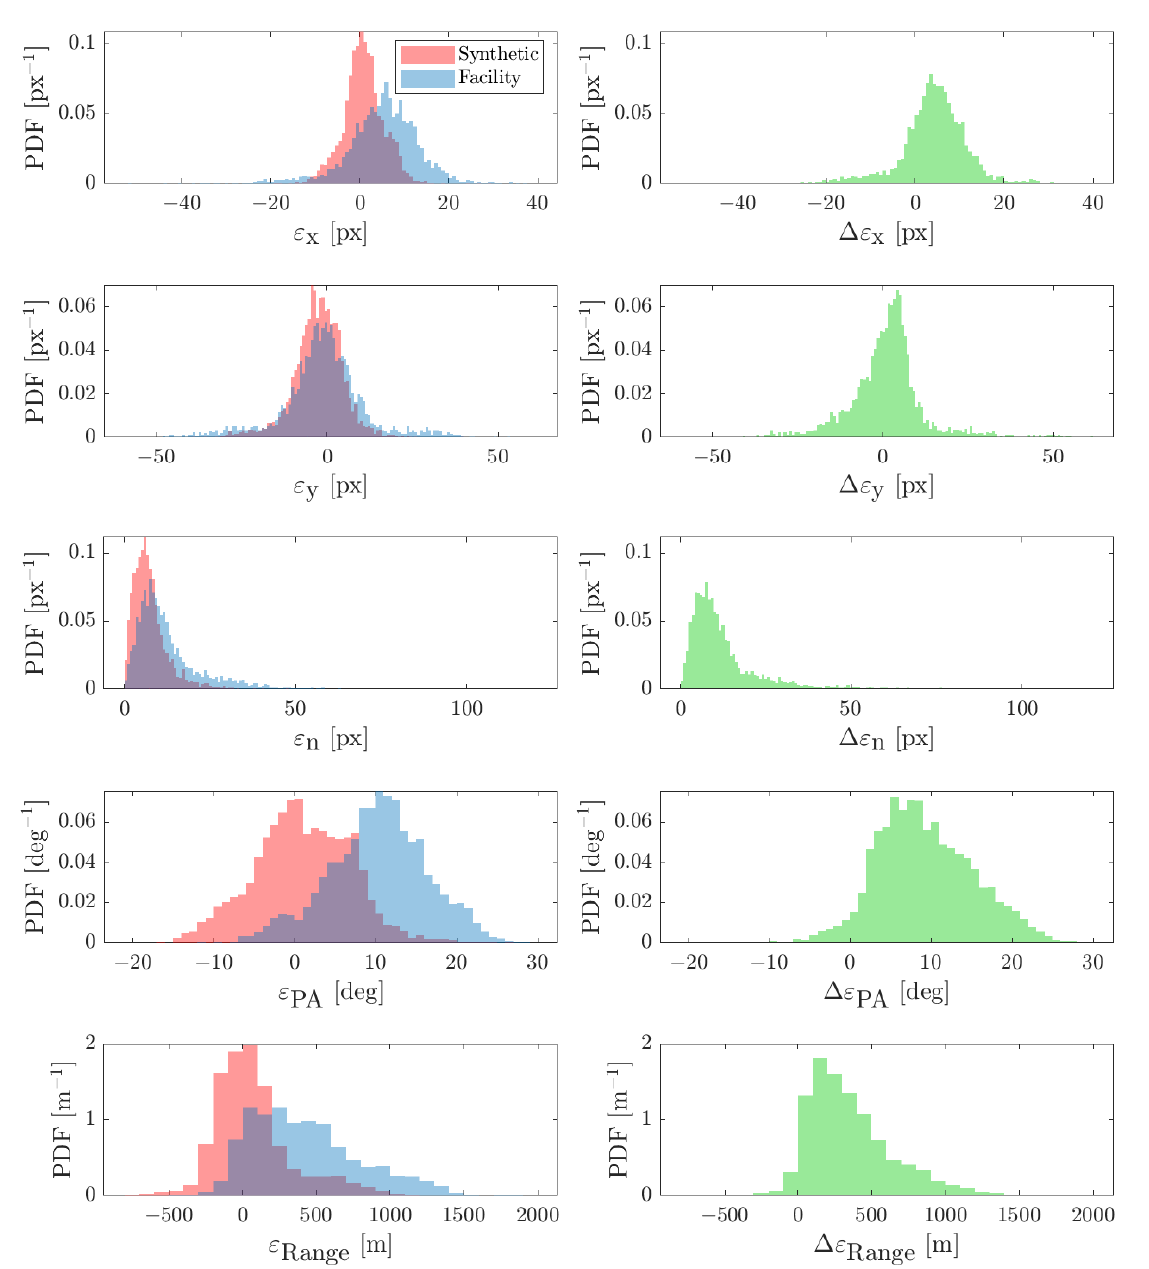
Figure 24. Results for the CRP dataset, shown as PDFs. ( Left ): Estimation error statistics. ( Right ): Difference between the IP output on facility images and the IP output on synthetic images (see Piccolo et al.